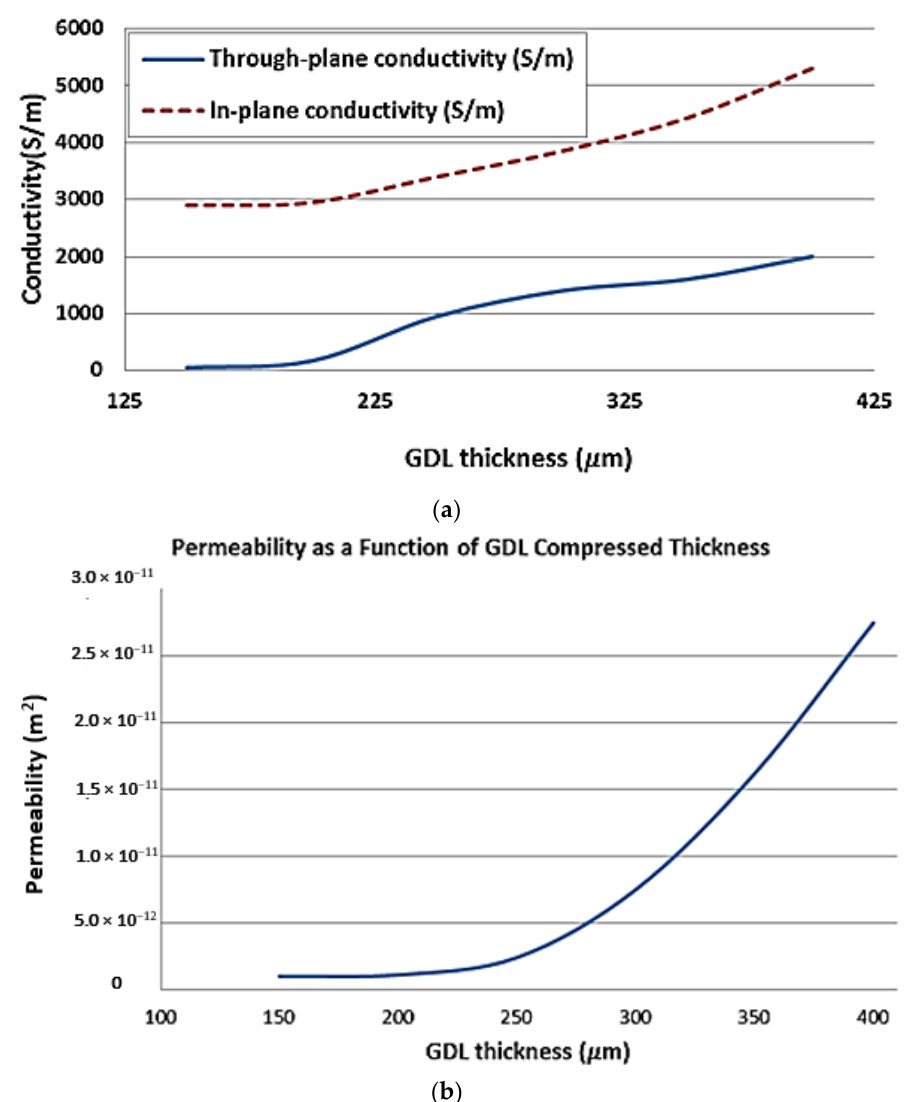
Figure 8. ( a ) Conductivity as a function of GDL compressed thickness, and ( b ) permeability as a function of GDL compressed thickness.